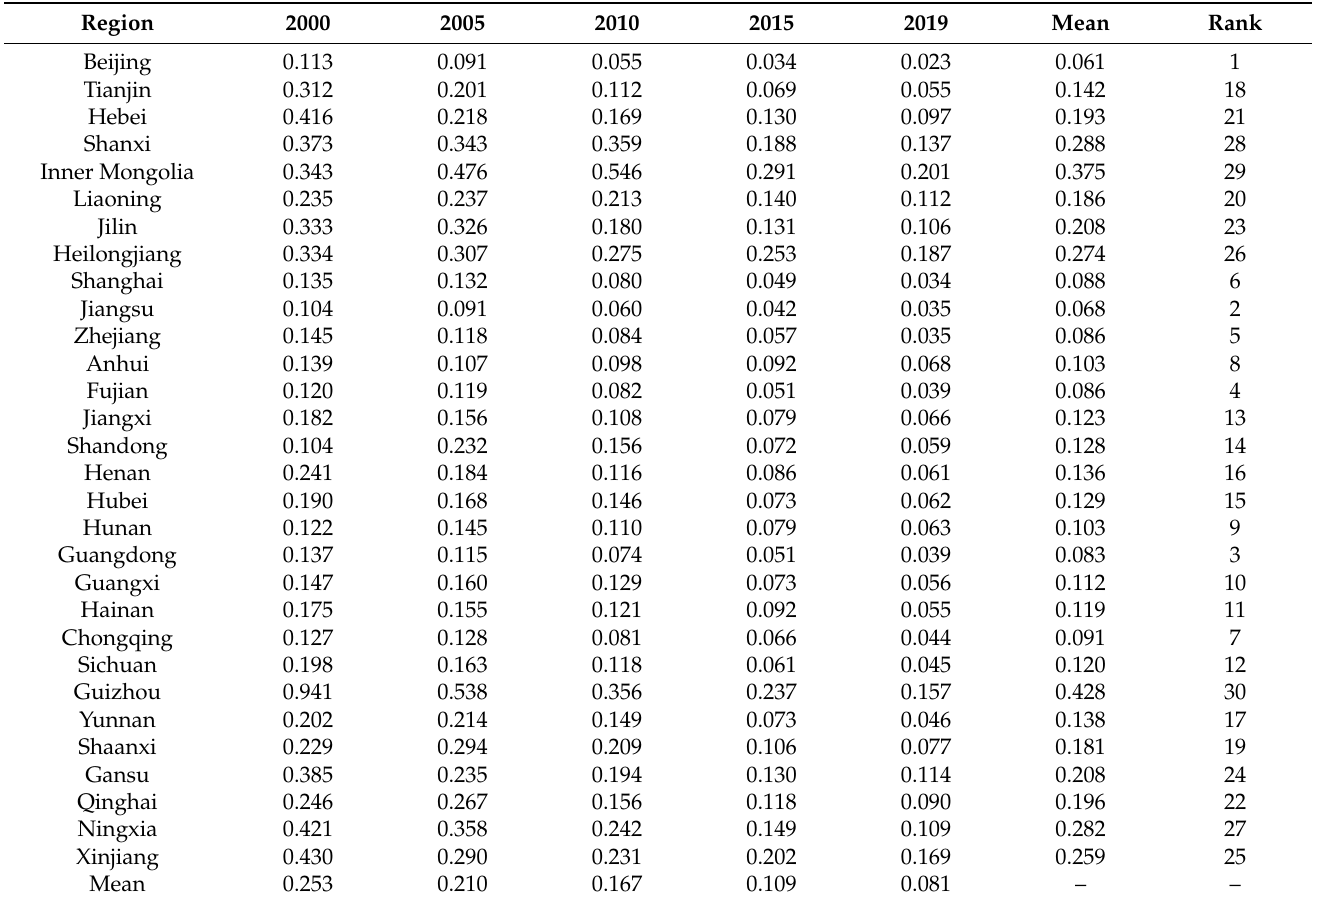
Table 3. The results of tourism carbon emissions efficiency (kgCO 2